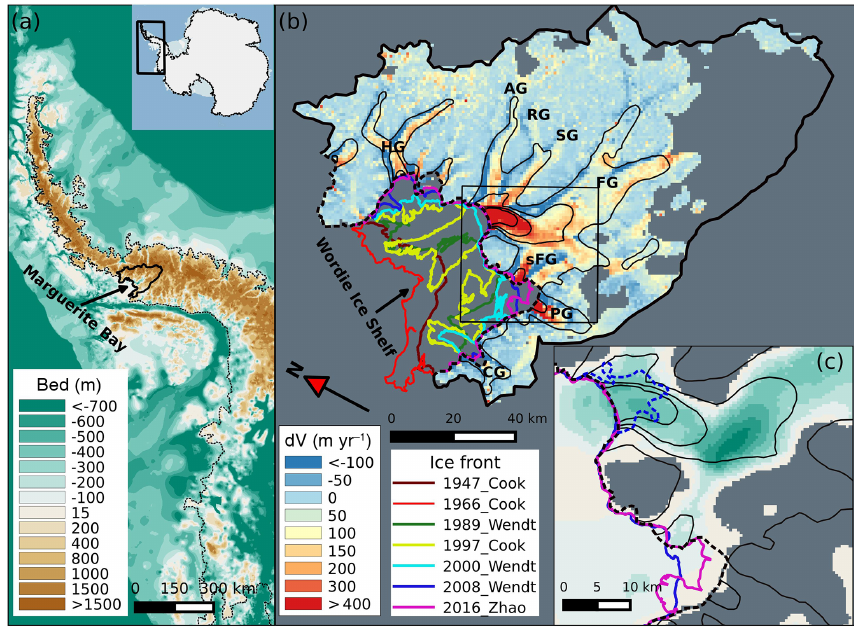
Figure 1. (a) The location of the study region in the Antarctic Peninsula (solid line polygon) with bedrock elevation data “bed_zc”, based on Bedmap2 (Fretwell et al., 2013) but refined using a mass conservation method for the fast-flowing regions of the Fleming Glacier system (Zhao et al., 2018). (b) Velocity changes of the Wordie Ice Shelf–Fleming Glacier system from 2008 (Rignot et al., 2011b) to 2015 (Gardner et al., 2018). Black contours representing the velocity in 2008 with a spacing of 500myr − 1 . The coloured lines represent the ice front positions in 1947, 1966, 1989, 1997, 2000, 2008, and 2016 obtained from Cook and Vaughan (2010), Wendt et al. (2010), and Zhao et al. (2017). The feeding glaciers for the Wordie Ice Shelf include three branches: Hariot Glacier (HG) in the north, Airy Glacier (AG), Rotz Glacier (RG), Seller Glacier (SG), Fleming Glacier (FG), southern branch of the FG (sFG) in the middle, and Prospect Glacier (PG) and Carlson Glacier (CG) in the south. The grey area inside the catchment shows the region without velocity data. (c) Inset map of the Fleming Glacier with ice front positions in 2008 and 2016, grounding line in 1996 (dashed black line) from Rignot et al. (2011a) and deduced grounding line in 2014 (dashed blue line) from Friedl et al. (2018). The background image is the bedrock from (a) and the black contours are the same ones as in (b)